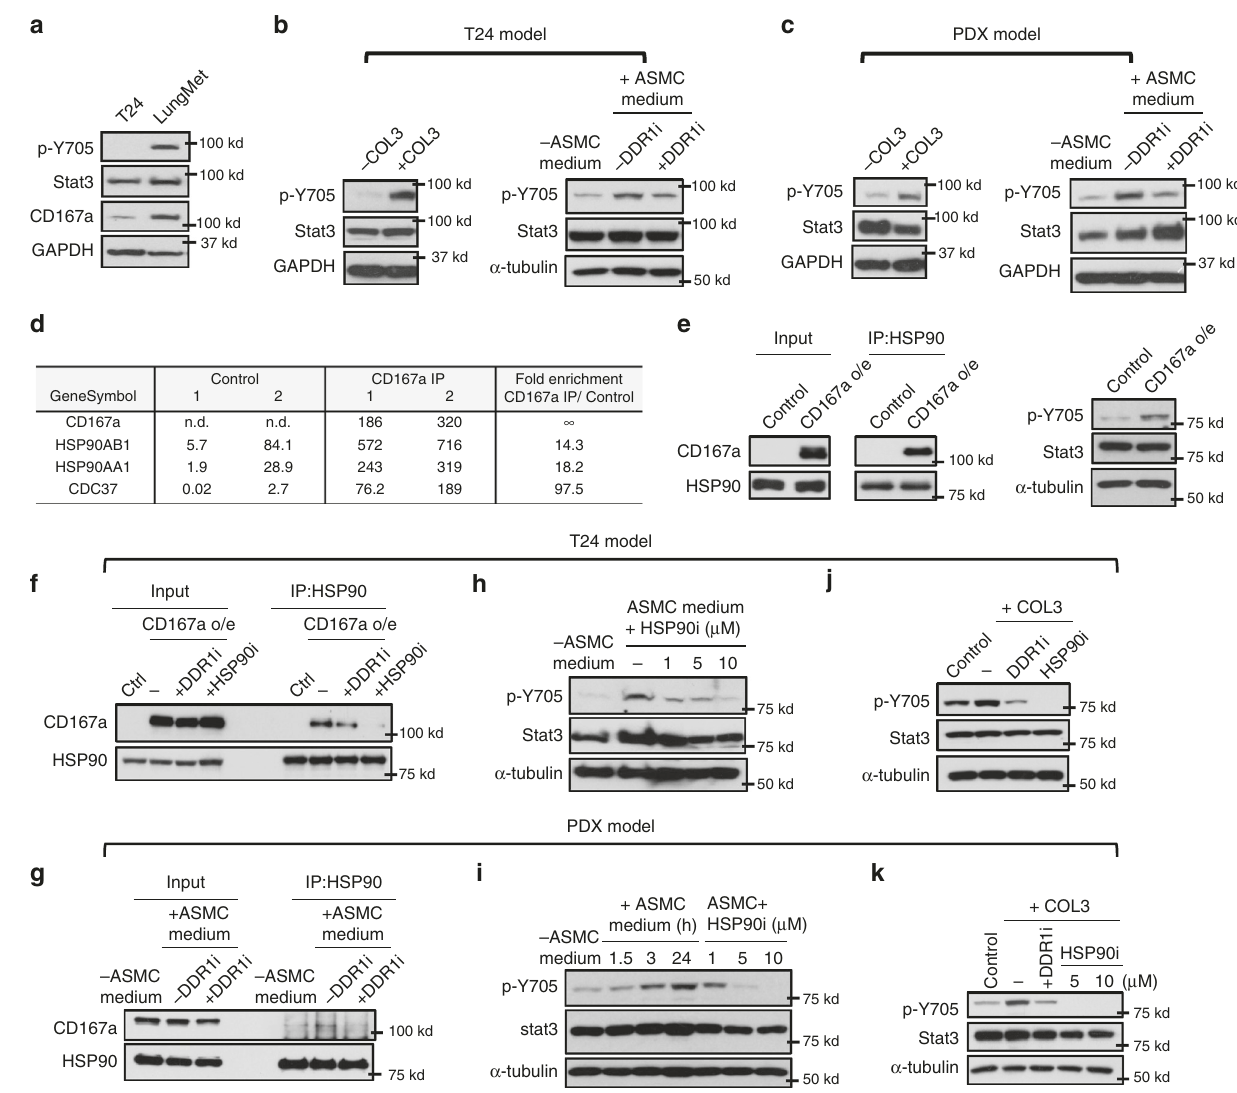
Fig. 6 CD167a-Stat3 axis in the COL3-rich airway smooth muscle cell metastatic niche in lung. a Western blot evaluating the relative protein expression of CD167a, Stat3 and phosphotyrosine Stat3 (Y705) in parental T24 cells and our newly-established metastatic model (T24-LungMET). b , c Effects of COL3, and ASMC-conditioned media and CD167a/DDR1 kinase inhibitor (DDR1-IN-1; 10 μ M) on Stat3 and phosphotyrosine Stat3 protein expression, in T24 and PDX models. d Coupling CD167a co-IP with mass spectrometry to discover CD167a-interacting partners. Selected CD167a associated gene protein products (GPs) and their corresponding iBAQ values are listed. e Coupling co-IP and western blot to evaluate CD167a-HSP90 interaction, via co-IP using anti-HSP90 antibody followed by western blotting of CD167a in control and CD167a-overexpressing T24 cancer cells. f Effects of CD167a kinase inhibitor (DDR1-IN-1, 10 μ M) and HSP90 inhibitor (Geldanamycin, 5 μ M) on CD167a-HSP90 complex formation. Control cells and CD167a-overexpressing T24 cancer cells were treated with COL3 in the absence or presence of indicated inhibitors for 24 h. Cell lysates were collected for co-immunoprecipitation assay using anti-HSP90 antibody. g PDX cells were cultured in control (-ASMC) or ASMCs conditioned media ( + ASMC) with or without DDR1-IN-1 inhibitor (10 μ M) for 24 h. Cell lysates were assessed for CD167a-HSP90 interaction by co-immunoprecipitation assay followed by western blot analysis. h , i Western blot analysis of Stat3 tyrosine phosphorylation upon treatment with ASMC-conditioned medium in the presence or absence of HSP90 inhibitor ( + HSP90i, 1, 5, and 10 μ M) in T24 and PDX models. j , k Western blot analysis of COL3-induced Stat3 tyrosine phosphorylation in T24 and PDX models upon treatment with CD167a/DDR1 kinase speci fi c inhibitor (DDR1-IN-1, 10 μ M) and Geldanamycin (HSP90i, 5 μ